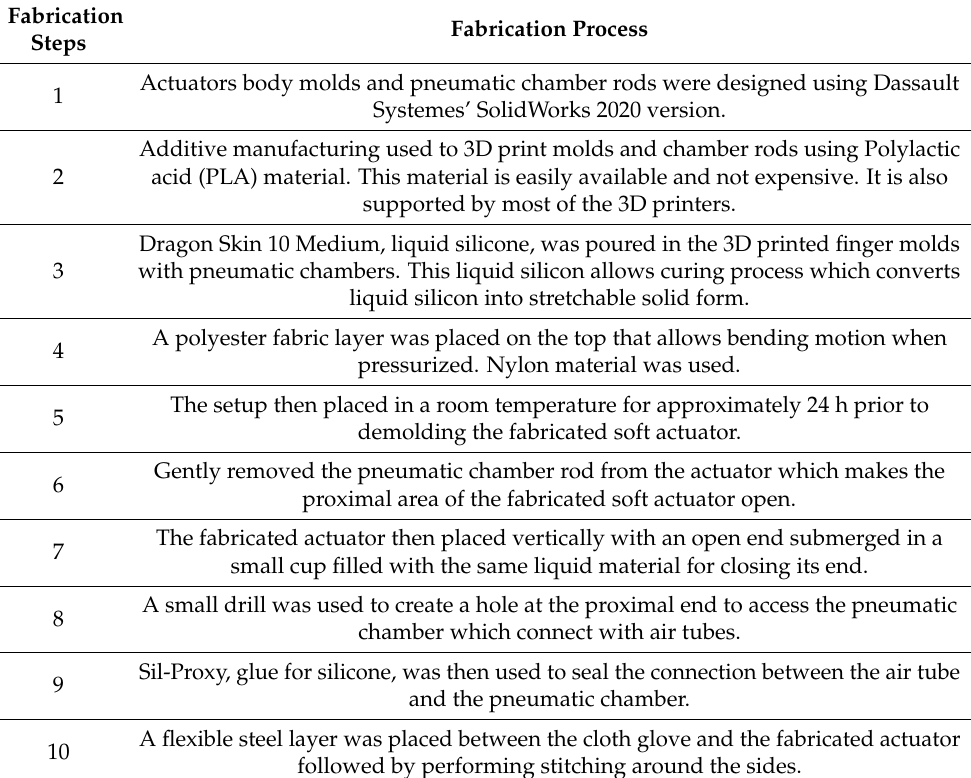
Table 1. Fabrication process